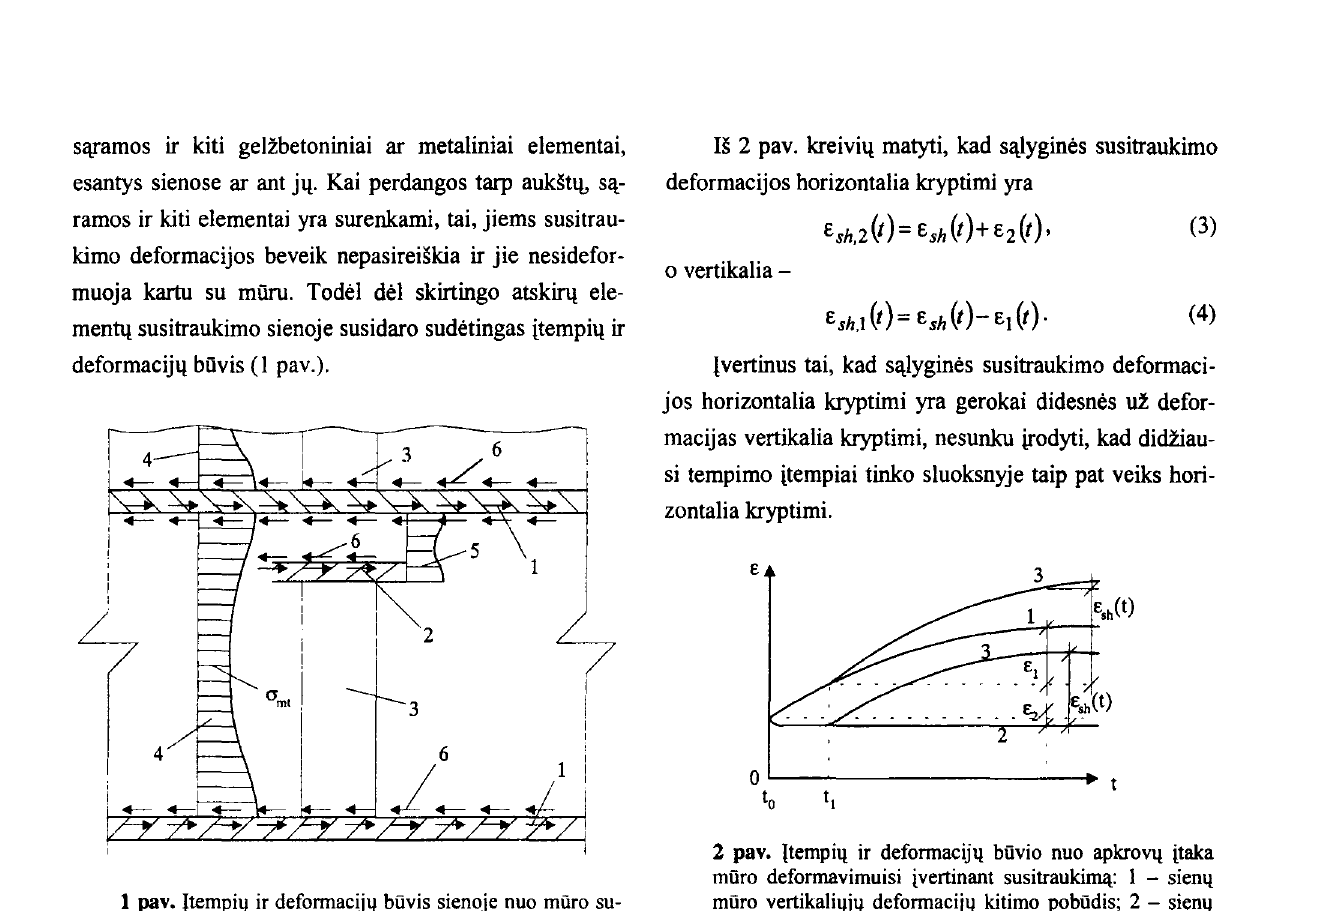
Fig 1. Stress-strain state in masonry wall depending on shrinkage: 1 - reinforced concrete floor; 2 - reinforced concrete straight; 3 - door opening; 4 - characteristics of stress-strain distribution according to the hight of wall; 5 - stress-strain form over the opening; 6 - shear forces be cause of different shrinkage Deformacijos nuo vertikaliai veikiancill itempill pa siskirsto priklausomai nuo N dydZio ir pobudZio. Jos su kelia ne tik vertikaliq_sias (Ex), bet ir skersines (horizon